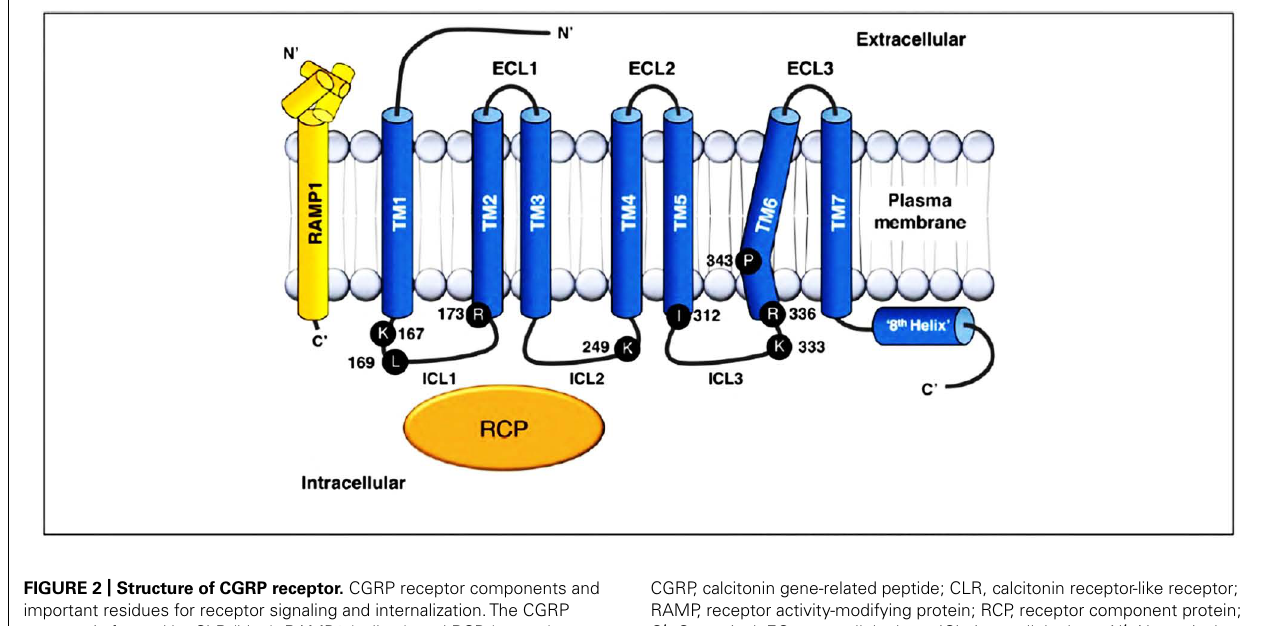
CGRP, calcitonin gene-related peptide; CLR, calcitonin receptor-like receptor; RAMP, receptor activity-modifying protein; RCP, receptor component protein; C (cid:3) , C-terminal; EC, extracellular loop; ICL, intracellular loop; N (cid:3) , N-terminal; TM, transmembrane. FromWalker etal. (2010), with permission.